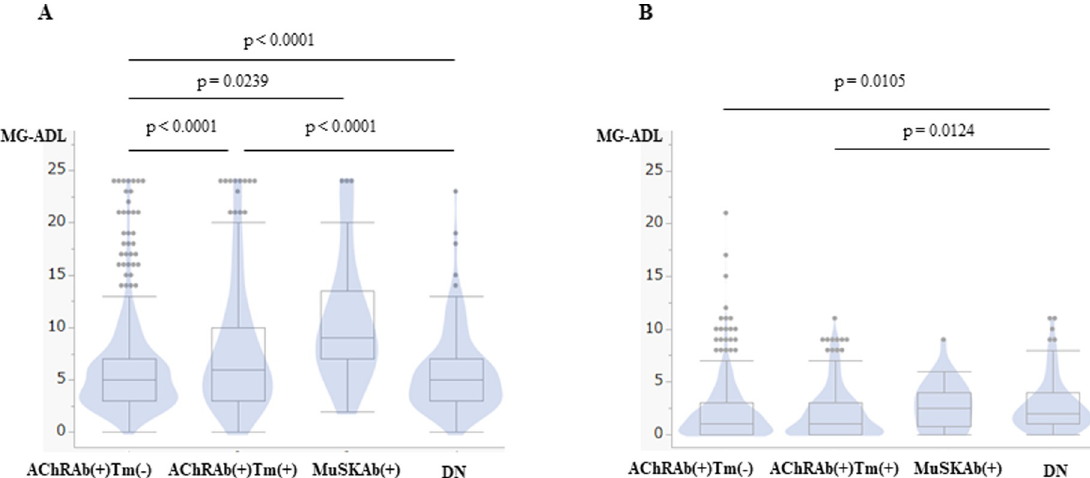
Fig 5. Myasthenia gravis activities of daily living profile by categories. (A) Box and violin plots of myasthenia gravis activities of daily living profile (MG-ADL) at the severest state. (B) Box and violin plots of MG-ADL at the current state. The horizontal line within the box represents the median value. The box ends represent the 25th and 75th quantiles, expressed as the first and third quartiles. The lines that extend from the box end are whiskers. The whiskers extend from the ends of the box to the outermost data point that falls within these distances. 1st quartile–1.5 x (interquartile range), 3rd quartile+1.5 x (interquartile range). For statistical analysis, Steel-Dwass All Pairwise Comparison was performed.